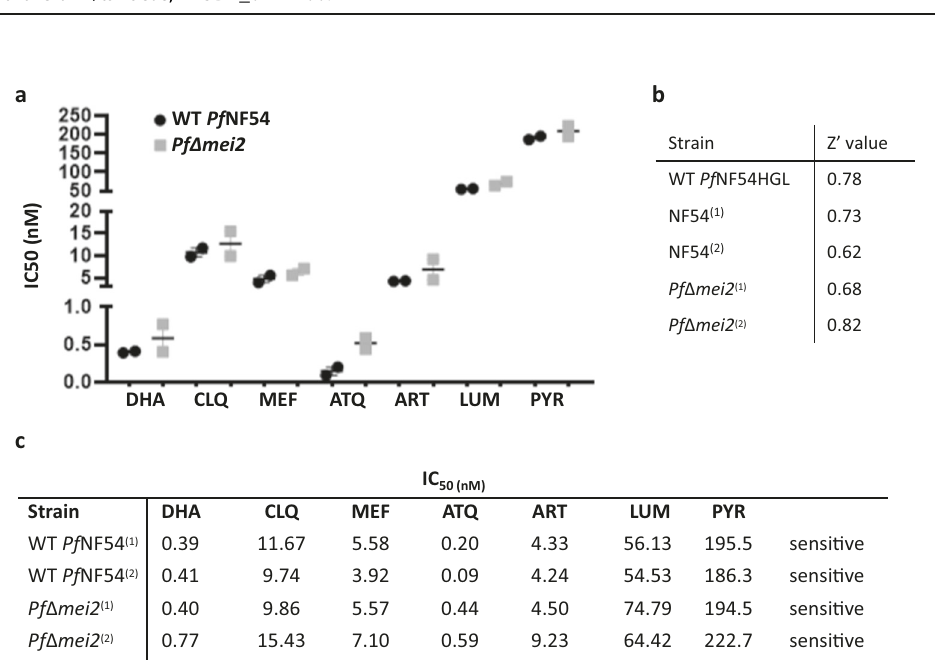
Fig. 4 Pf Δ mei2 genome sequence analysis. a The mei2 locus of Pf Δ mei2 . No sequence reads are mapped on the mei2 coding sequence while reads map in the mei2 up- and downstream regions. b Sequence of the mei2 locus of Pf Δ mei2 . The mei2 fl anking regions are unaltered and the expected mei2 deletion event is shown by the preservation of the mei2 targeting sequences (yellow). The mei2 coding sequence (in red) is absent (start and stop codon in green). c Uniquely mapped sequence read (Illimina reads) coverage of heterologous sequences used in the DNA constructs/plasmids for generation of Pf Δ mei2 . None of the sequences ( ampicilin , h dhfr- y fcu, blasticydin, fl pe, and cas9 ) were mapped with sequence reads from the Pf Δ mei2 genome. d Read coverage, InDel, and SNP information of the following endogenous 5 ′ - and 3 ′ - utr sequences, used in DNA constructs/plasmids to drive gene expression. These sequences were unaltered in the Pf Δ mei2 genome. The regions were: 5 ′ UTR: calmodulin , PF3D7_1434200; Hsp 70, PF3D7_0818900; Hsp90 , PF3D7_0708400; 3 ′ UTR: Hpr2 , PF3D7_0831800; Hsp90 , PF3D7_0708400; and the dhfr/ts locus, PF3D7_0417200.